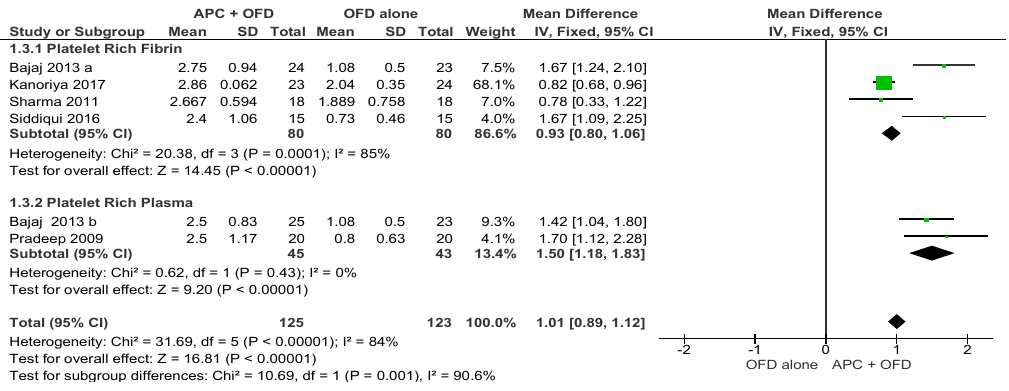
Figure 7. Forest plot showing the effect on horizontal clinical attachment level for comparison of APC + OFD versus OFD alone at end of all-follow-up (6–12 m) .